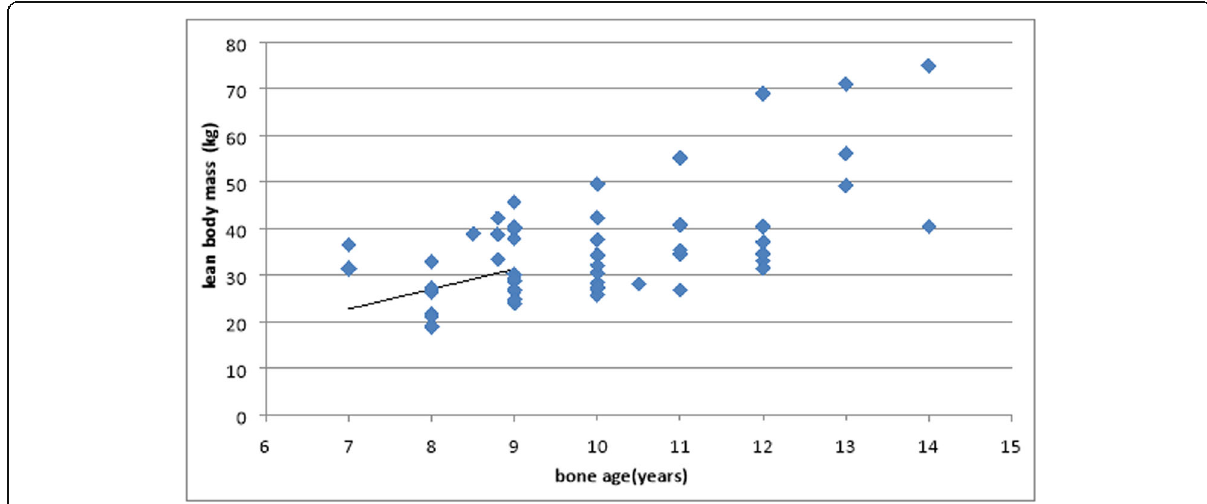
Fig. 6 Correlation between bone age and body mass in